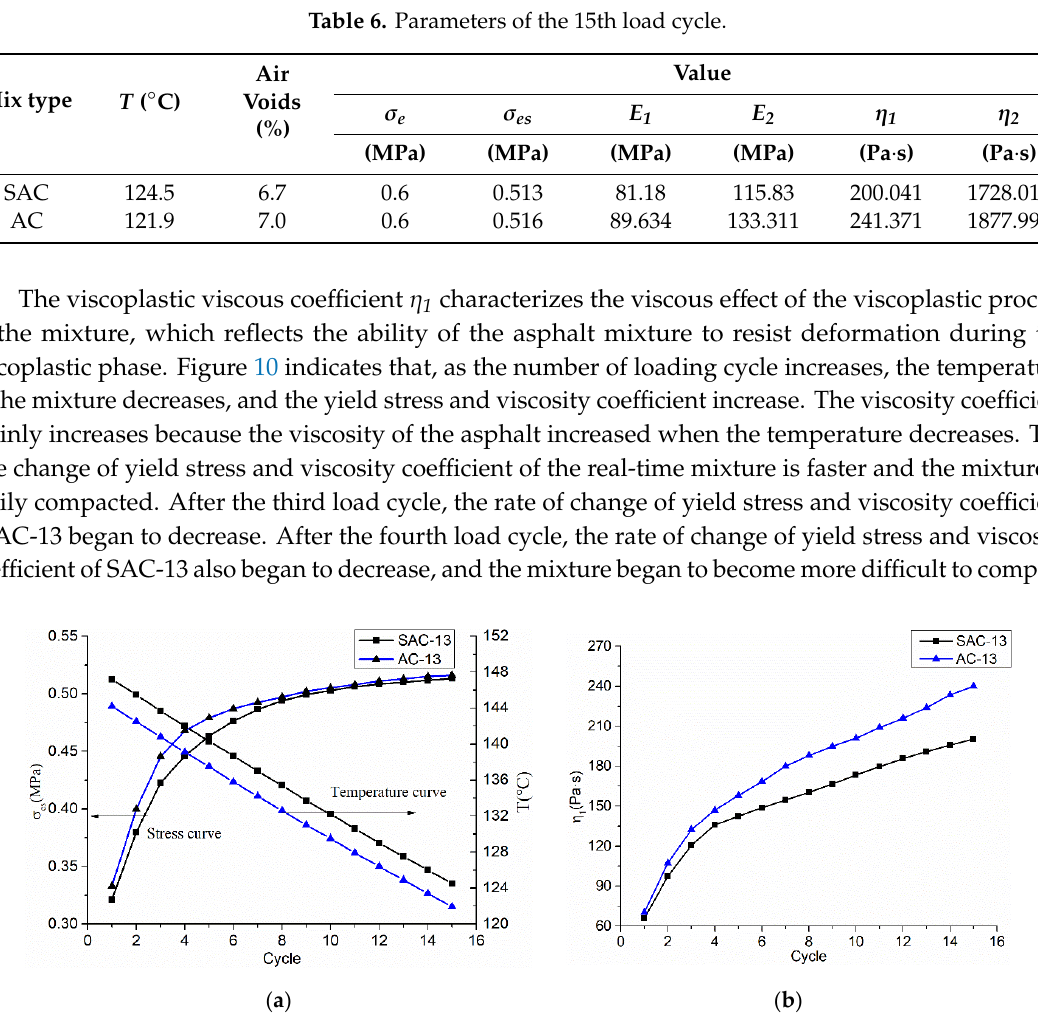
Figure 11. Air voids curves changing with the load cycle times.